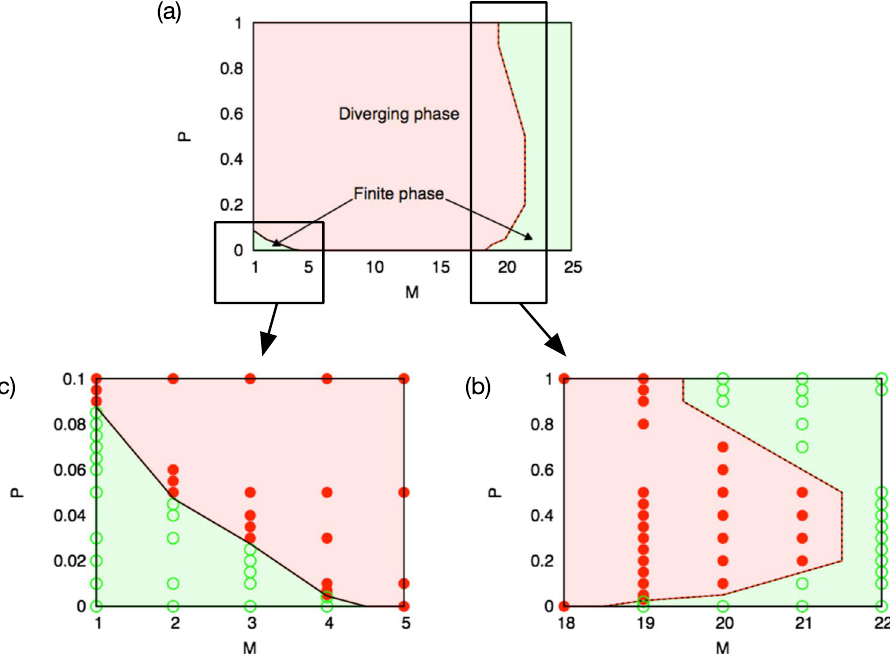
Figure 4. The phase diagram of the growth behavior for ( a ) 1 ≤ M ≤ 22, ( b ) the dense interaction regime 18 ≤ M ≤ 22, and ( c ) the sparse interaction regime 1 ≤ M ≤ 5. The partial bidirectionality expands the area of the diverging phase (filled circles). There exists an upper phase boundary (dotted line) at around 18 < M < 22 and a lower phase boundary (solid line) at around 1 ≤ M < 5. The upper boundary is asymmetric for the bidirectionality and there is an optimum bidirectionality for the growth rate at around P ~ 0.3. The finite phase (open circles) in the sparse connecting regime M < 5 remains within a range of small but finite bidirectionality. The area of the finite phase gradually decreases as a function of the increasing bidirectionality.